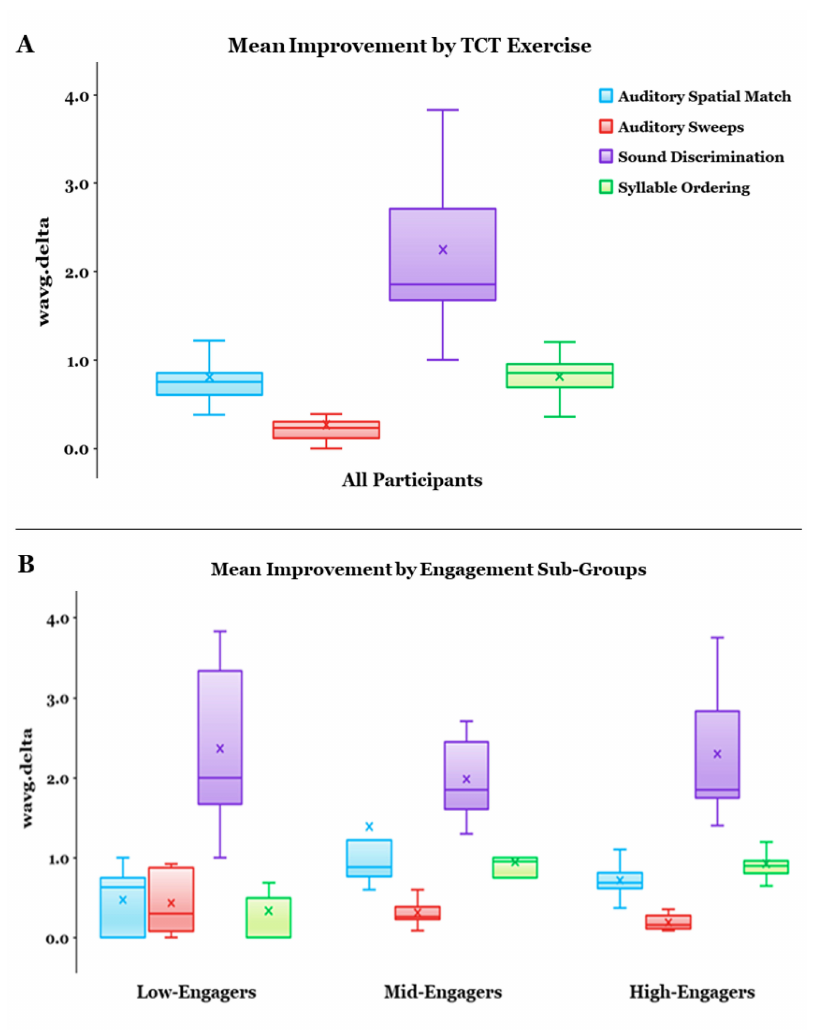
Figure 1. ( A ) Mean weighted average performance change (wavg.delta) for each auditory-based targeted cognitive training (TCT) exercise, calculated by taking the difference between participant- specific best and baseline performance divided by the standard deviation of baseline performance across all study participants. ( B ) wavg.delta for each TSC-Based Engagement Sub-Group suggests that non-completers (Low-/Mid-Engagers) demonstrate improvement on tasks in a pattern similar to completers (High-Engagers). However, data from low-engagers should be interpreted with caution as their limited exposure to the TCT exercises was likely insufficient to effect/measure meaningful